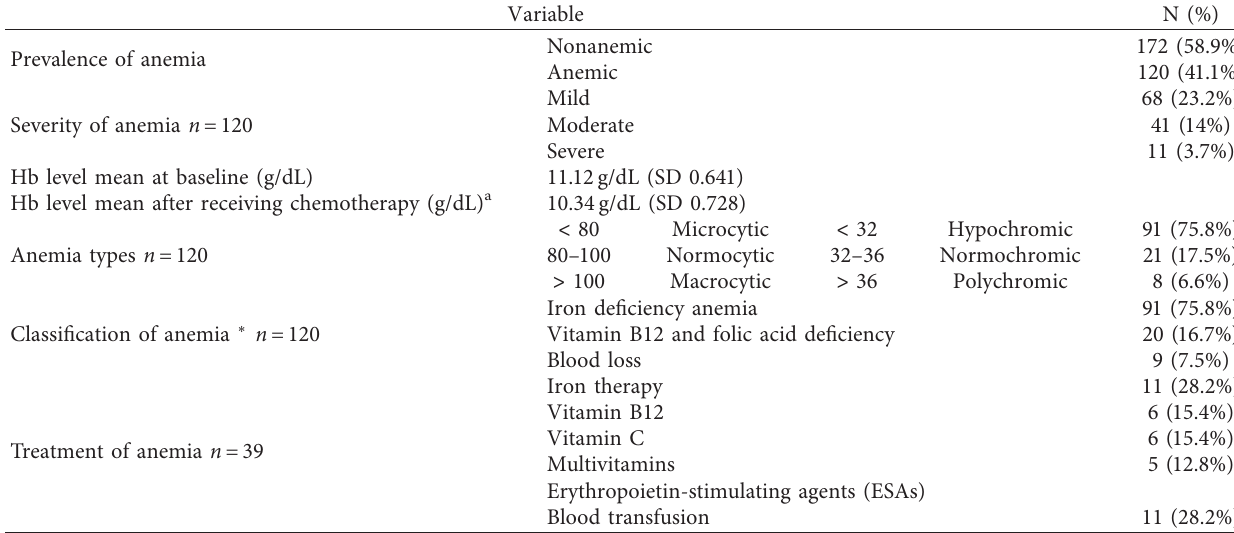
Table 2: Data of anemia among breast cancer patients receiving chemotherapy ( n � 120).